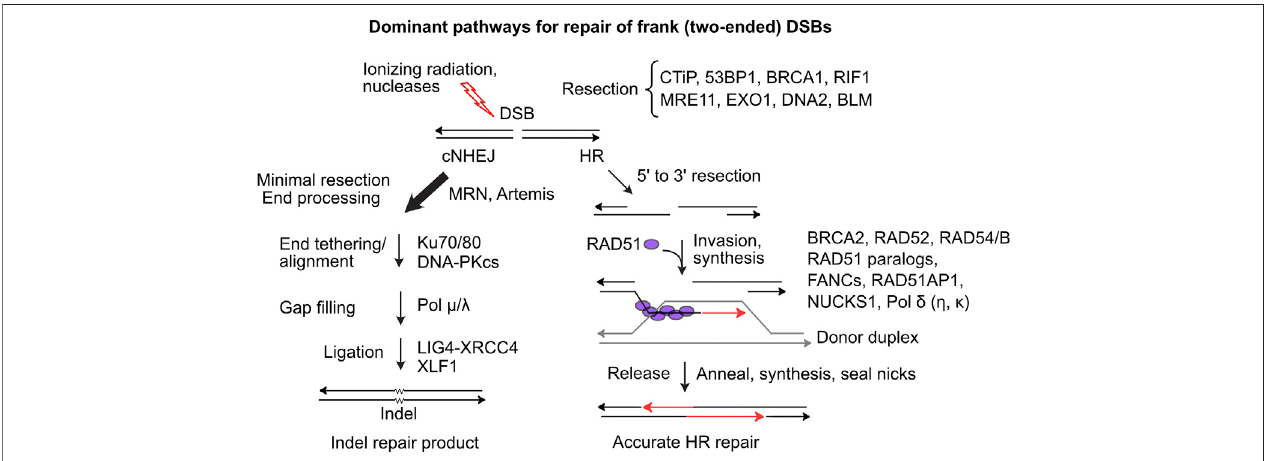
FIGURE 1 | Dominant two-ended DSB repair pathways. (Left) cNHEJ is the dominant pathway for repairing two-ended DSBs. cNHEJ acts on blunt or minimally processed ends bound by Ku70/Ku80 and DNA-PKcs. Short gaps are fi lled and ends are ligated to complete repair, typically with small insertions or deletions at the repair junction (Right) HR initiates with 5 ′ -3 ′ resection and binding of ssDNA by RPA, which is replaced by RAD51 in a reaction mediated by BRCA2 and RAD51 paralogs. The RAD51 nucleoprotein fi lament invades homologous duplex DNA, assisted by RAD54, RAD54B and other factors. RAD51 dissociates and the invadingendisextendedandthenreleasedallowingpairingtossDNAontheoppositesideoftheDSB.Gapsare fi